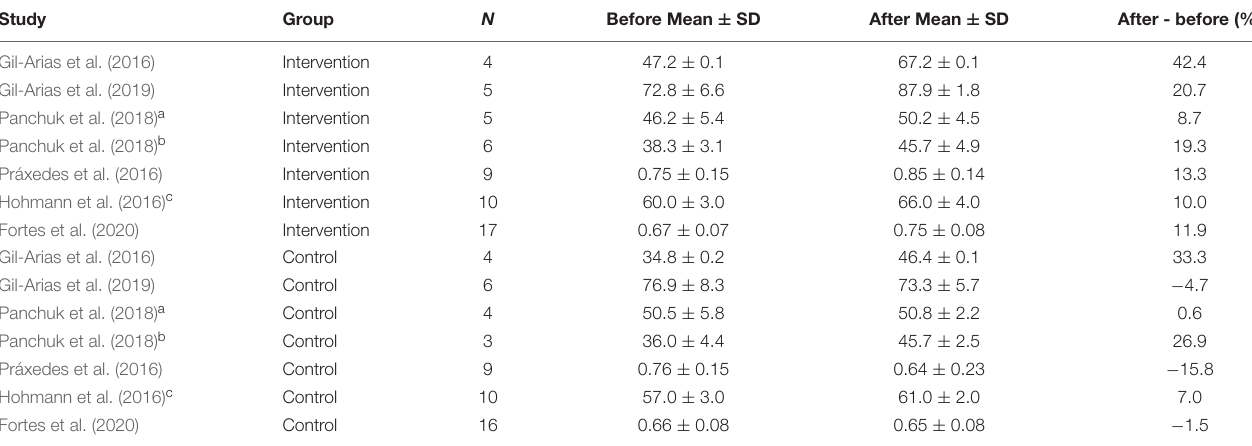
TABLE 6 | Summary of the included studies and results of tactical behavior before and after